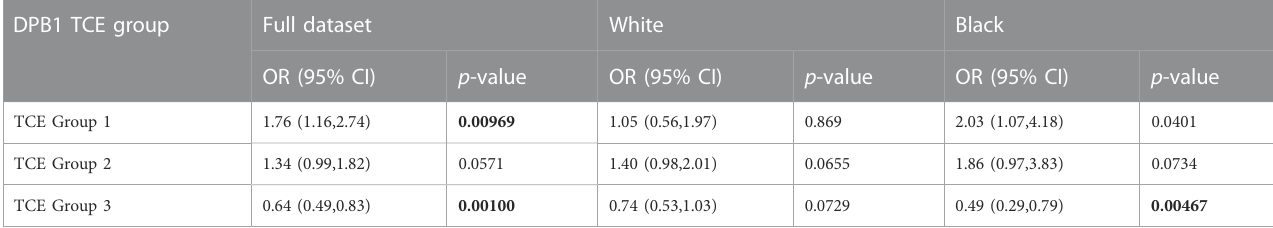
TABLE 8 Associations between DPB1 TCE groups and Atopic Dermatitis in the GAD cohort. Correction factor of 3 ( p < 0.0167; bold text). DPB1 TCE group